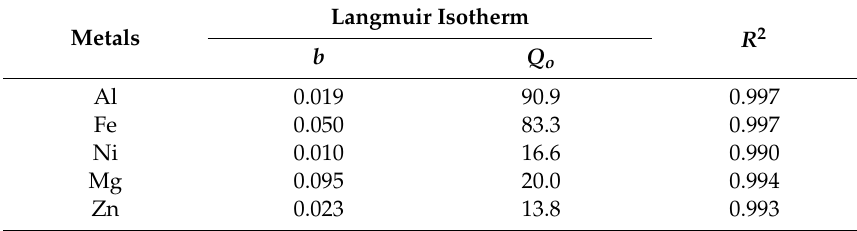
Table 1. Parameters of Langmuir isotherm for ion exchange of metals on